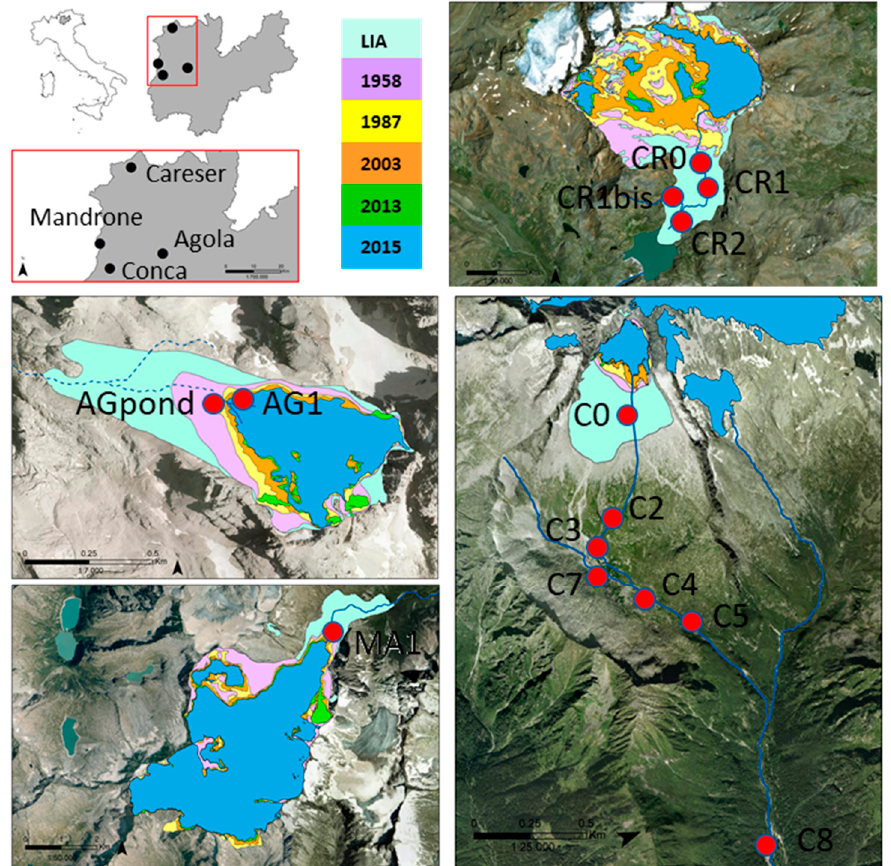
Figure 1. The four glacial systems studied in the Italian Alps (46 ◦ N, 10 ◦ E, Trentino Province). Glacier surface in 2015 (blue color): Conca = 0.14 km 2 , Agola = 0.19 km 2 , Careser = 1.39 km 2 , Mandrone = 10.14 km 2 [45]. Codes of sites are in Table 1. LIA, Little Ice Age [46]. Orthophotos are from the geoservice of Trento Province. The glacier surface data source: [45]. Sampling sites are denoted by red circles.